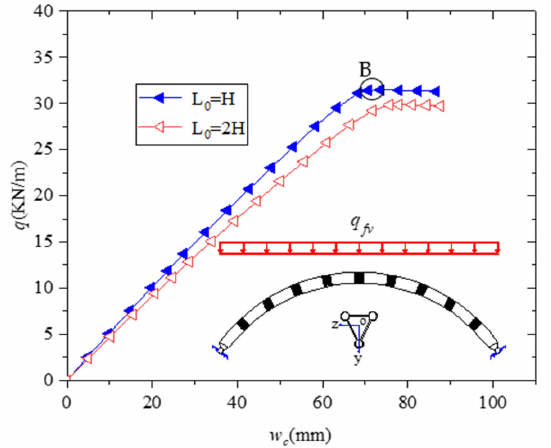
Figure 14. Internal force distribution along the arch axis under FSUVL ( f bending moment; ( c ) shear force. ( b ) bending moment; ( c ) shear force.